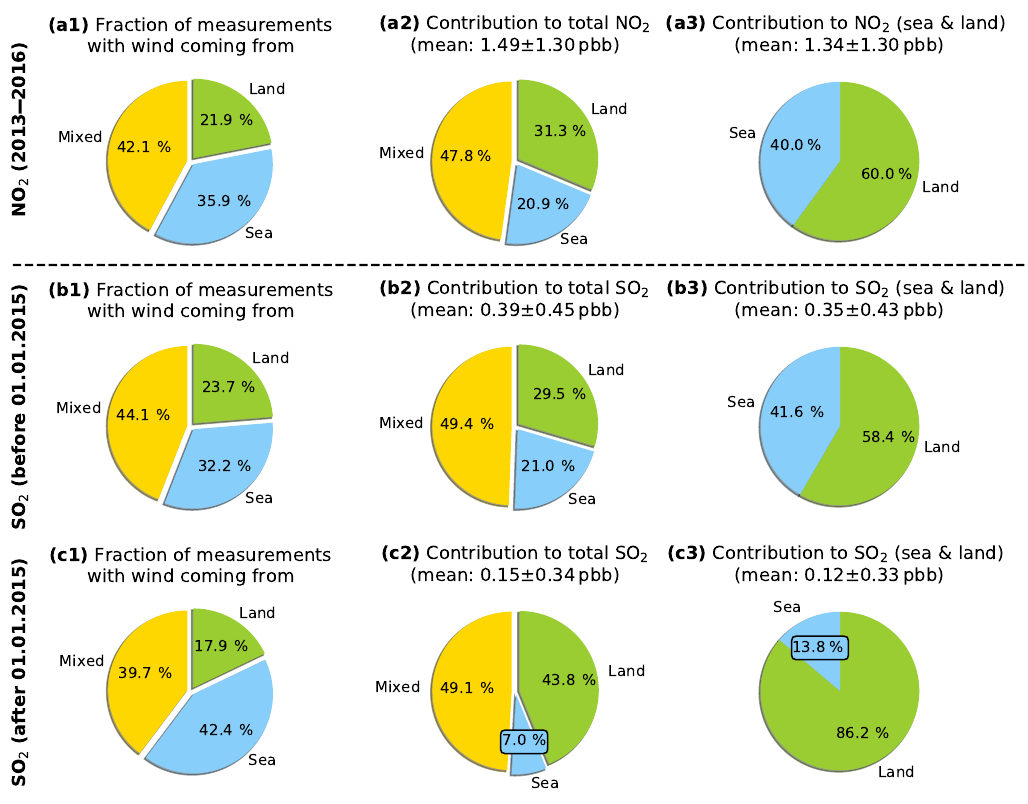
Figure 17. Contributions of ships and land-based pollution sources to measured NO 2 and SO 2 levels on Neuwerk: (a1) , (b1) and (c1) . Percentage of measurements with wind coming mainly from land (green), only from sea (blue) and from directions with mixed contributions (yellow) for all NO 2 data (a1) and SO 2 data before (b1) and after the change in fuel sulfur content limits (c1) . (a2) , (b2) and (c2) : contri- butions to the integrated volume mixing ratios of NO 2 (a2) and SO 2 (b2, c2) from the source regions as a percentage. (a3) , (b3) and (c3) : contributions to the integrated volume mixing ratios when considering only the land and sea sectors. It can clearly be seen that the lower fuel sulfur limit has led to a strong decrease in the SO 2 contribution from shipping since